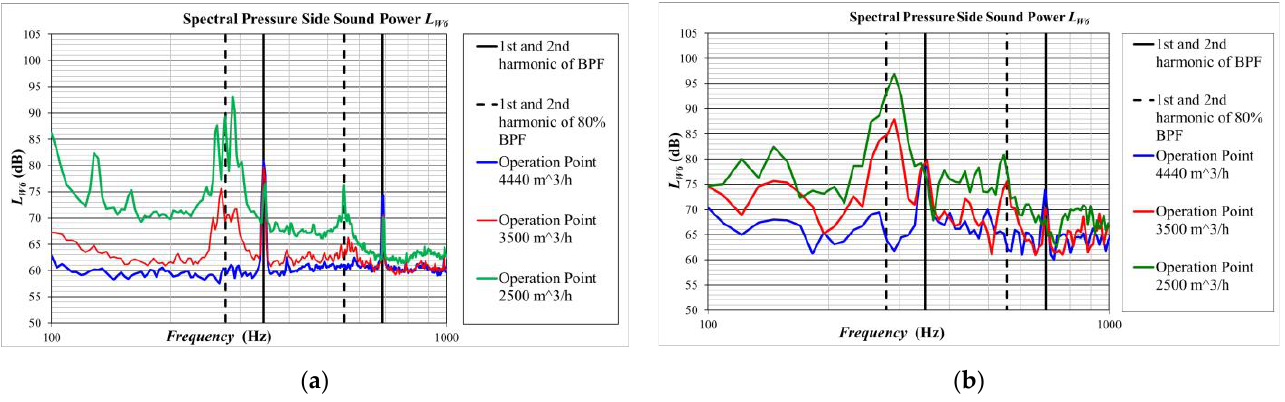
Figure 4. Comparison of spectral results: ( a ) review of the experimental spectral results of Figure 2b; ( b ) numerical spectral results of the pressure side sound power level L W 6 for the same three operation points ( b ).